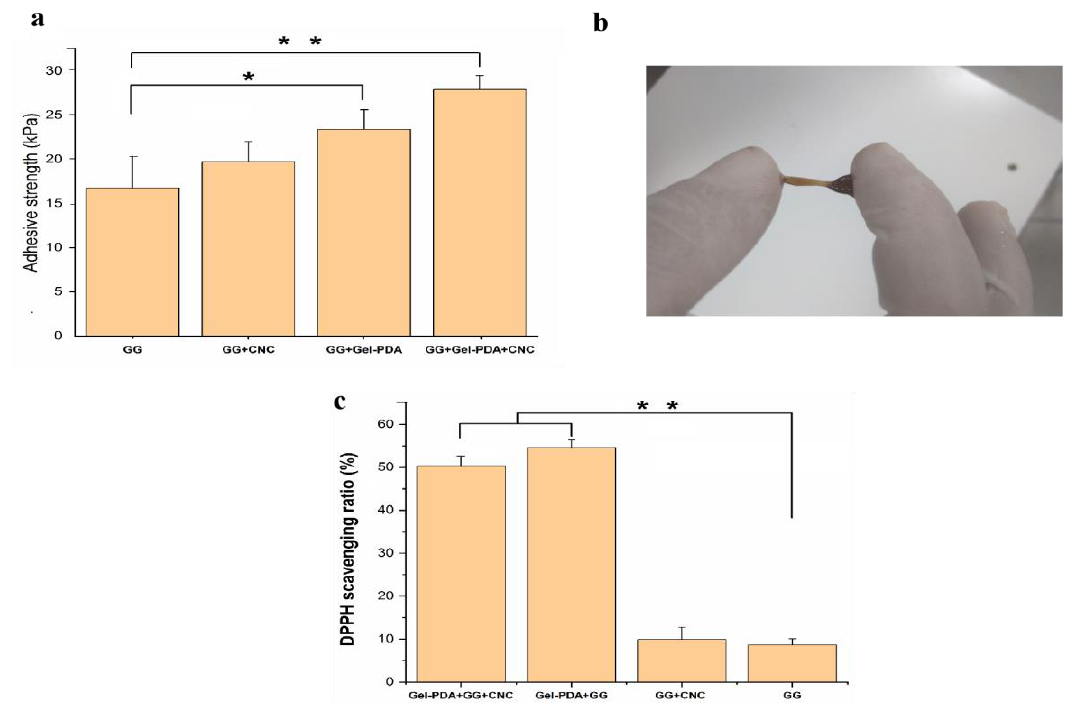
Figure 5. Adhesion and anti − oxidant activity analysis of hydrogels. ( a ) Skin adhesion strength of hydrogels (* p < 0.05, ** p < 0.01), ( b ) macroscopic adhesion image of Gel − PDA+GG+CNC hydrogel between fingers, ( c ) DPPH radical scavenging activity of hydrogels (** p < 0.01).